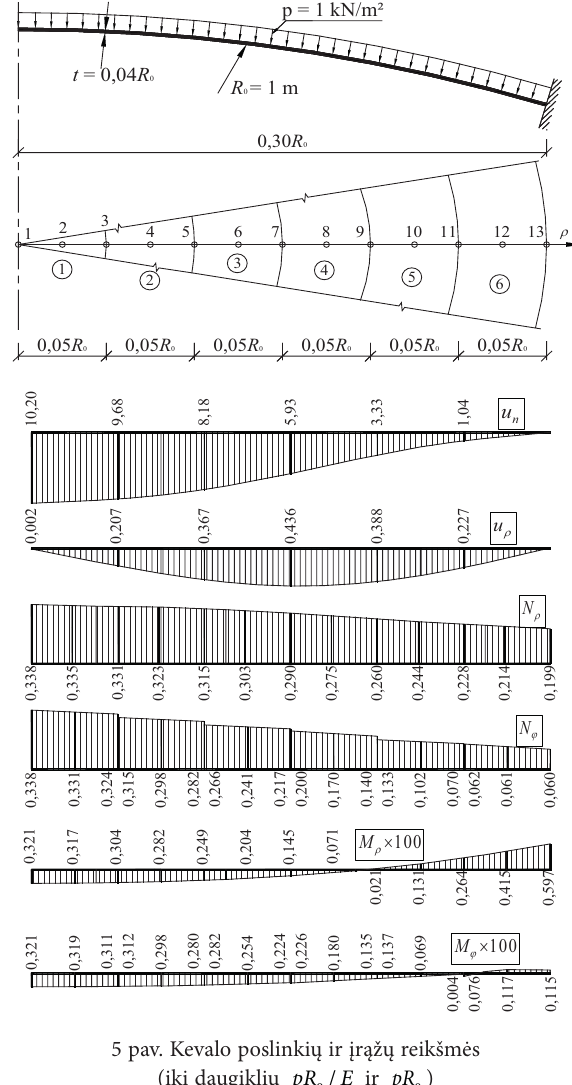
/ pR E ir 0 / pR E and pR 0 0